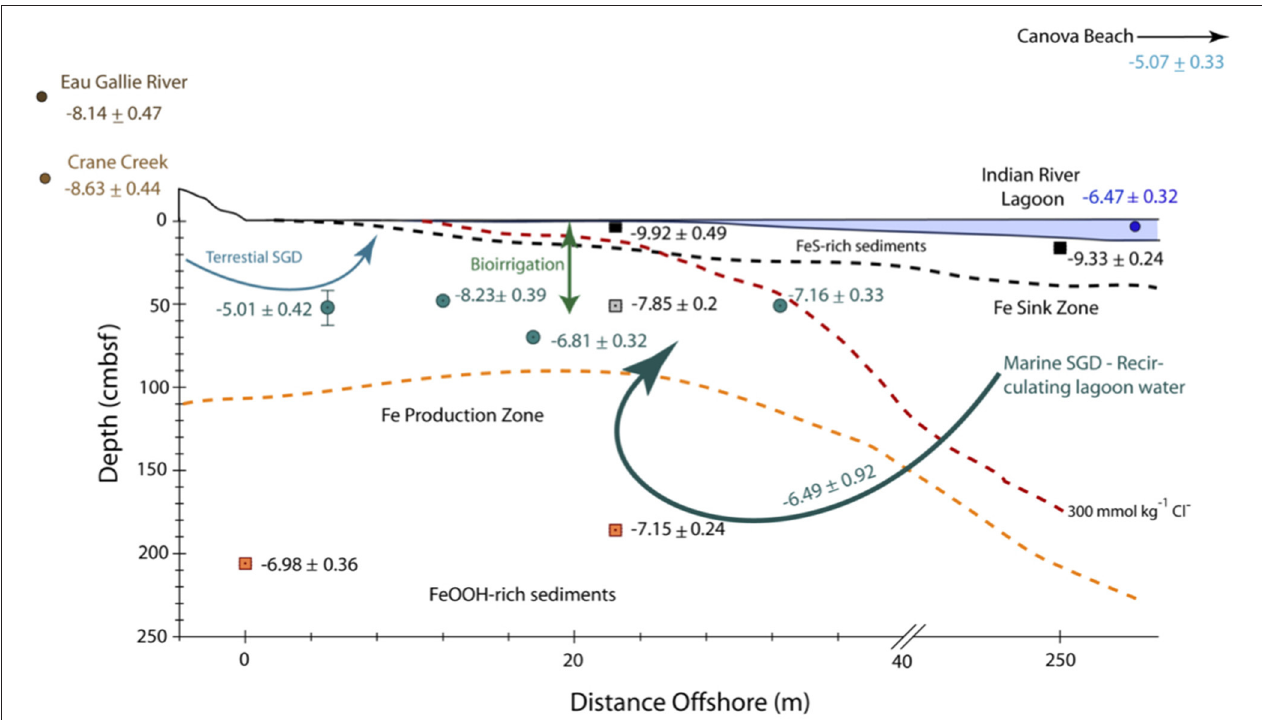
FIGURE 7 | Schematic cross section and conceptual model through the nearshore transect and a portion of the offshore transect (i.e., > 40m offshore) of the Indian River Lagoon subterranean estuary showing the approximate distance offshore (in meters) and depth (in cm below the seafloor, cmbsf) of water samples (filled circles) and sediment samples (filled squares) along with their corresponding ε Nd (0) ± 2 σ values. Note, the horizontal scale is in meters, whereas the vertical scale is in cm. The dashed red line refers to the 300 mmol kg − 1 Cl − concentration that represents the seepage face as described by Roy et al. (2010). The orange dashed line shows the approximate upper boundary of the Fe production zone, which is defined by the dissolved Fe concentration maxima across the nearshore transect, whereas the black dashed line represents the approximate upper boundary of the Fe sink zone defined by the bottom of the Fe sulfide-rich, black sediment layer within the subterranean estuary (see Roy et al., 2010, 2011, for details). Curved arrows show schematic flow paths for terrestrial SGD, the ε Nd (0) value of which (-5.01 ± 0.42) is characterized by groundwater from multisampler EGN-5, and recirculated lagoon water of largely marine origin (i.e., Marine SGD) characterized by groundwaters from multisamplers EGN-17.5 ( ε Nd = − 6.81 ± 0.32) and EGN-30 ( ε Nd = − 7.16 ± 0.33). Bioirrigation is schematically depicted for the nearshore transect by the double-headed